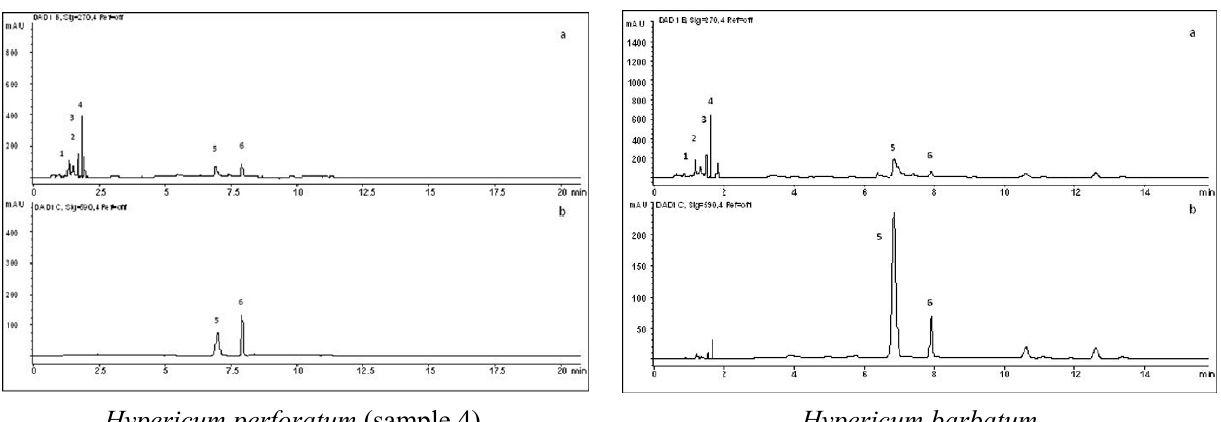
Figure 1. Sample chromatograms for Hypericum perforatum (sample 4) and Hypericum barbatum , with detection at 270 ( a ) and 590 nm ( b ) (1-chlorogenic acid, 2-caffeic acid, 3-rutin, 4-quercitrin, 5-hyperforin,